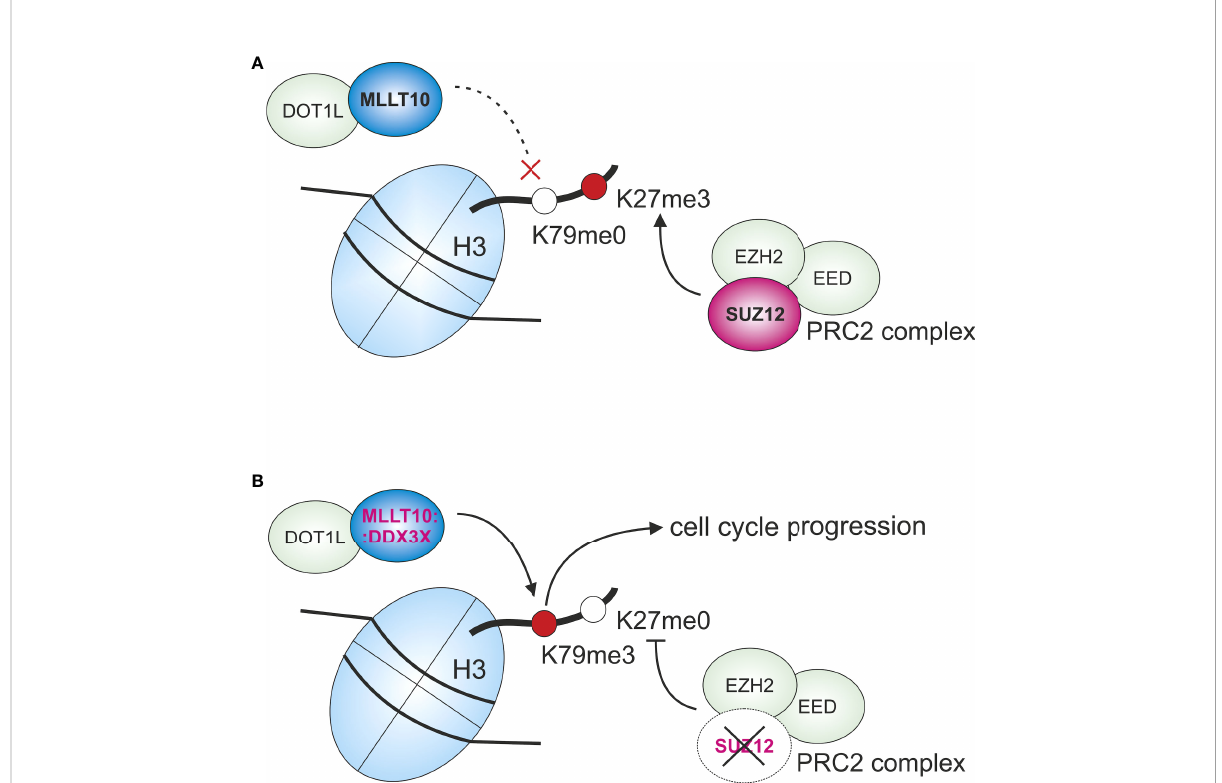
FIGURE 3 Graphic overview of interactions regarding histone 3 methylation with the participation of SUZ12 and MLLT10 under physiological conditions (A) and in the leukemic cells as suspected here (B) . (A) Under physiological conditions, PRC2 complex with SUZ12 and EED, and EZH2 methylates H3K27. This methylation abrogates the binding of DOT1L complex. (B) With SUZ12 being deleted, H3K27 is not methylated, which leads to binding of DOT1L complex and thereby to methylation of H3K79. This binding is probably additionally intensi fi ed because of DDX3X: MLLT10 gene fusion, enabling transcription of genes that promote, among other effects, cell cycle progression, e.g., HOXA genes. H, histone; Me,